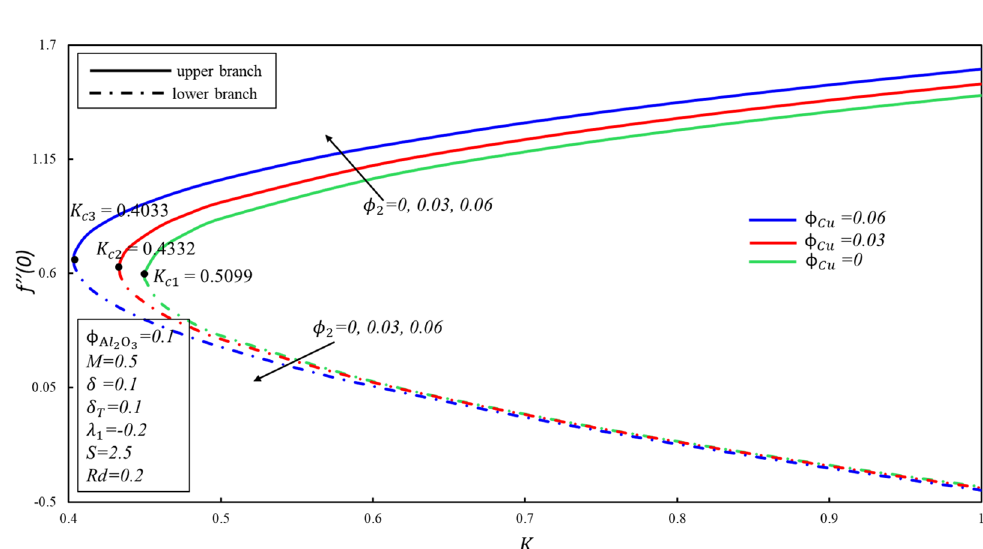
θ ′ ( 0 ) in impact of φ Cu . −